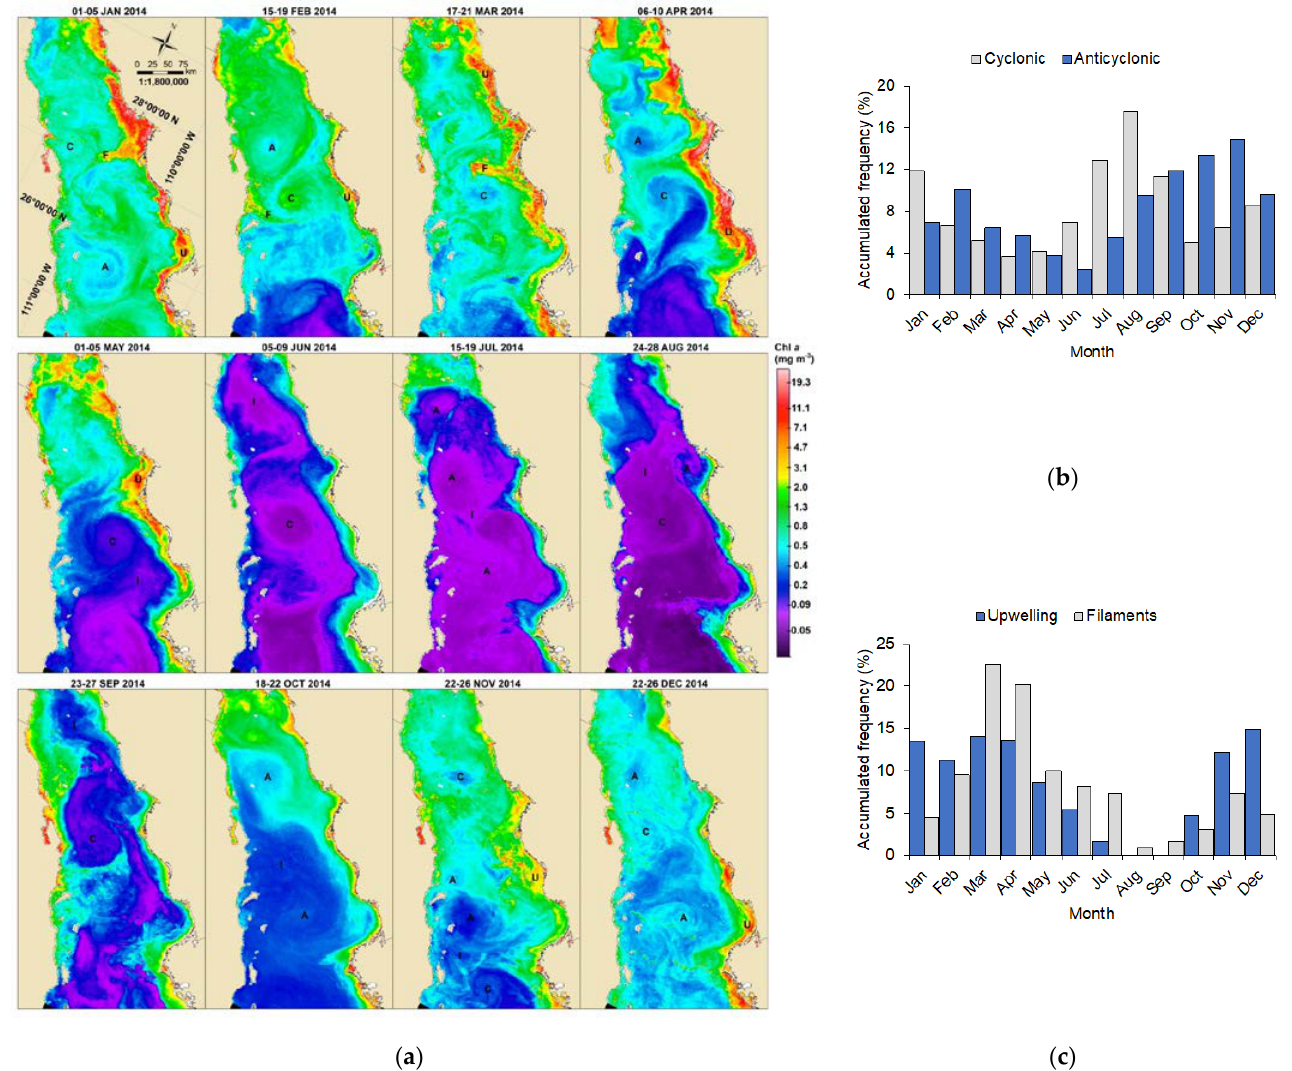
Figure 4. Annual frequency of mesoscale events in the Central Gulf of California. ( a ) Satellite images of chlorophyll a concentration (mg m −3 ) characterizing a typical year (2014) for anticyclonic eddies (A), cyclonic eddies (C), coastal upwelling (U), filament (F); Percentage of the accumulated annual frequency of ( b ) cyclonic and anticyclonic eddies; ( c ) coastal upwelling and filaments.